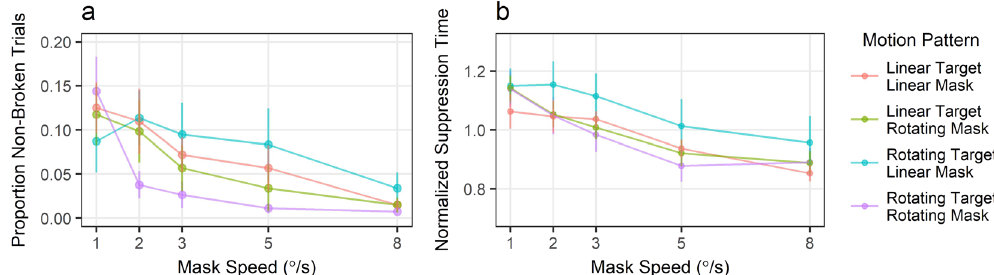
Figure 2. The relationship between the mask speed and target/mask motion patterns in Experiment 1. ( a ) Proportion of non-broken (no-response) trials. Although there was a tendency for the rotating mask to be less effective, there was no effect of matching target and mask motion pattern. ( b ) Suppression times normalized by subject means across conditions. Dots are group means with error bars reflecting standard